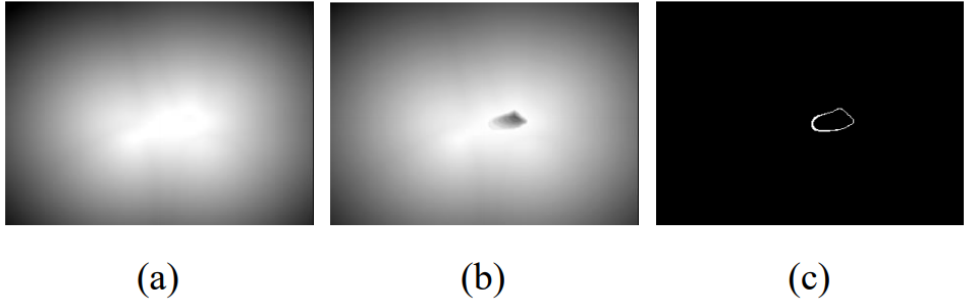
Figure 3. Schematic diagram of the distance map generated by the three methods. ( a ) Euclidean distance map; ( b ) Error compensation distance map; ( c ) Edge labeled distance